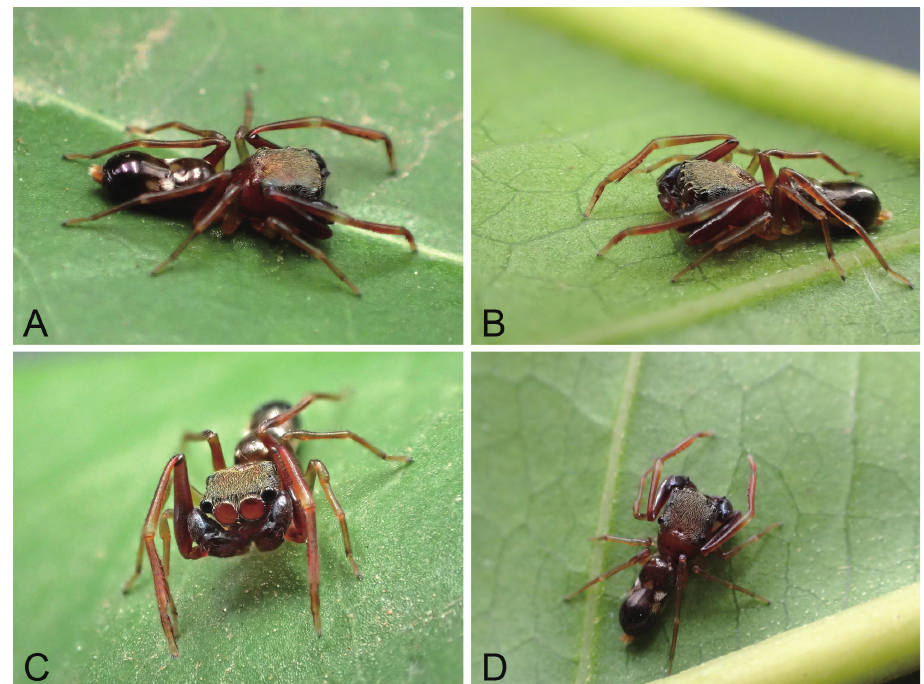
Figure 11. Photographs of living male specimens of Synagelides shuqiang sp. nov., from Ganzhou City in Jiangxi Province,